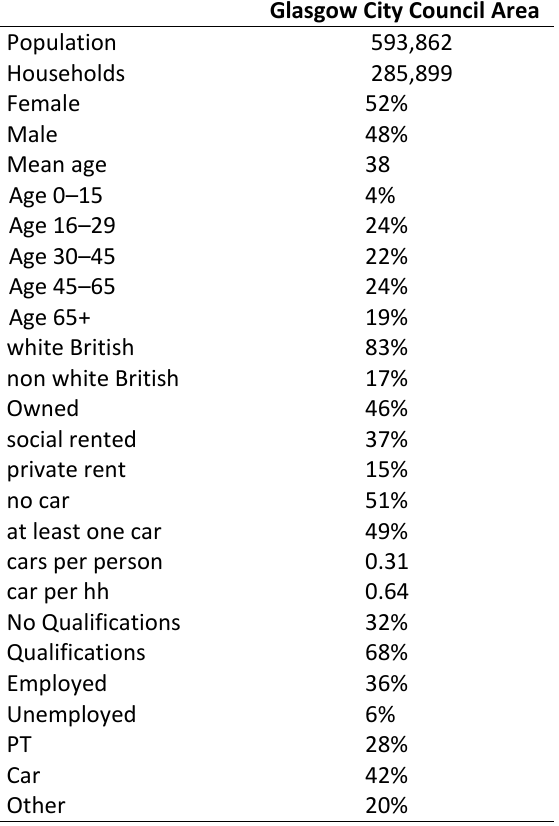
Table 1. Population characteristics of Glasgow. Source: Census 2011.